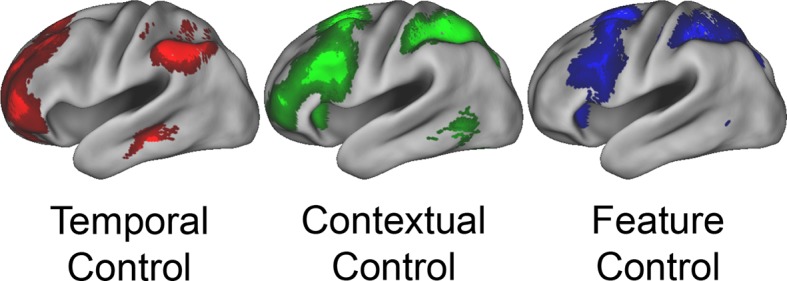
Univariate whole-brain results.Temporal demands of cognitive control produced a gradient of activation along the rostral/caudal axis of the LPFC. Temporal Control activated the rostral LPFC (red), Contextual Control the mid LPFC (green), and the interaction relating to Feature Control the caudal LPFC (blue). All results are corrected for multiple comparisons. Darker colors: p<10–3; Brighter colors: p<10–8 (Temporal Control, Feature Control) or p<10–12 (Contextual Control) to better visualize peaks.DOI:
http://dx.doi.org/10.7554/eLife.12112.00610.7554/eLife.12112.007Figure 3—source data 1.Statistical parametric maps of the univariate whole-brain results.Maps contain t-statistics and have been thresholded to correct for multiple comparisons as detailed in the Materials and methods.